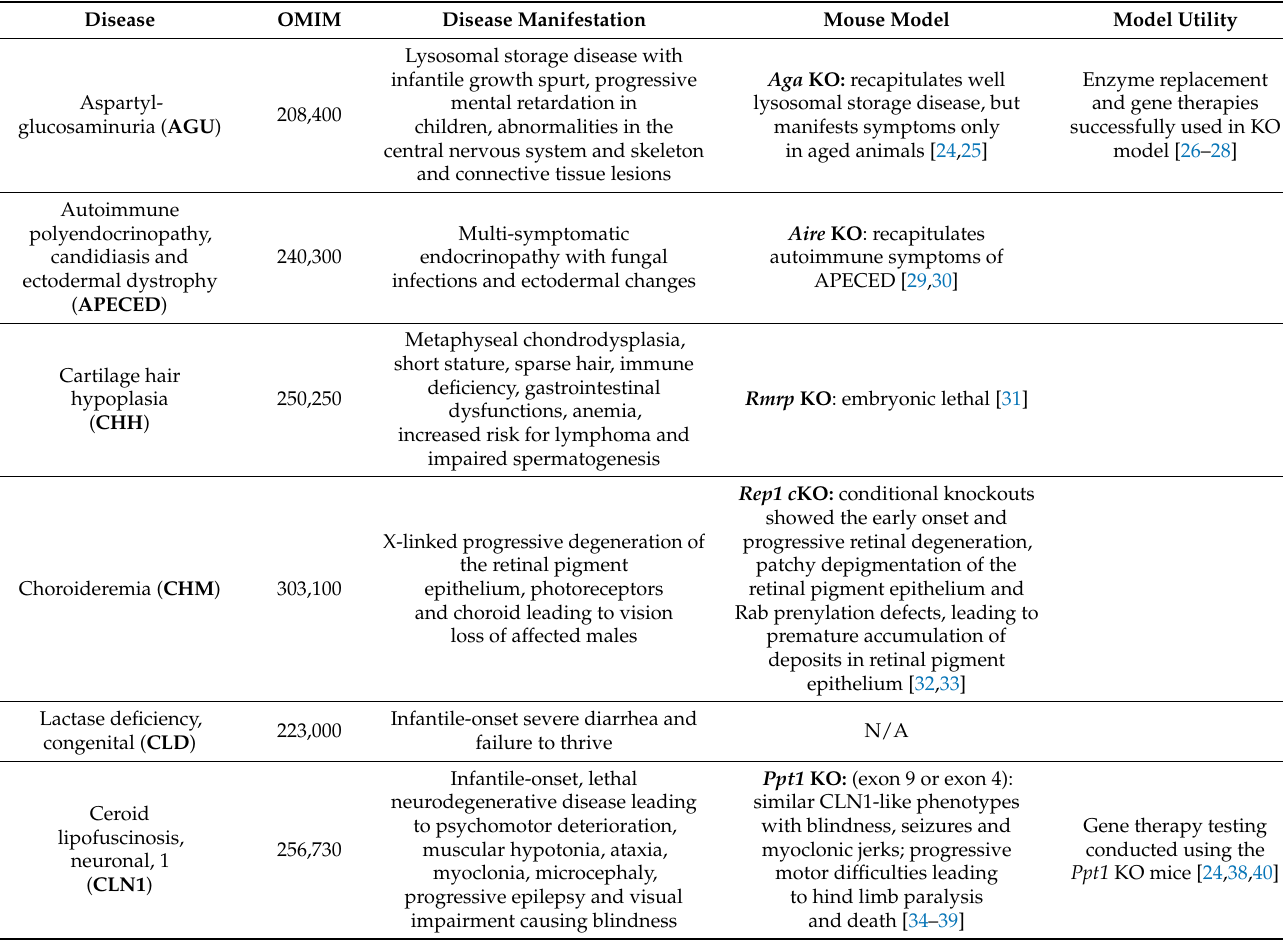
Table 2. Description of characteristic clinical features of FDH diseases and respective studies in possible knockout (KO), transgenic (TG) or knock-in (KI) mouse model(s).